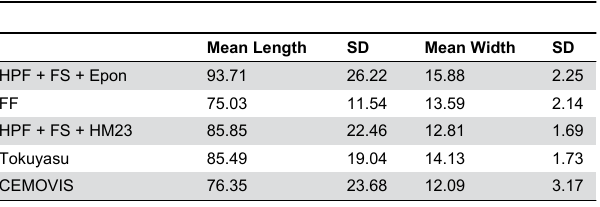
Table 2. Mean values of length and width of the sticks according to different TEM techniques.